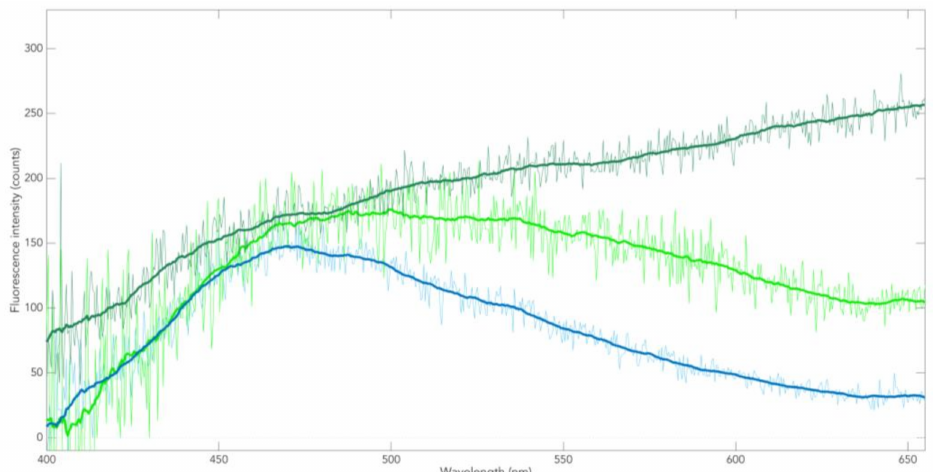
Figure 6. Examples of fluorescence spectra of postmortem SNpc of control case. The blue line represents a spectrum from a largely neuromelanin (NM)-free region; this fluorescence is the tissue autofluorescence from NAD(P)H. The other two spectra represent—from light to dark green—increasing contribution of NM fluorescence to the autofluorescence; the dark-green lined spectrum results from regions with maximum NM content.